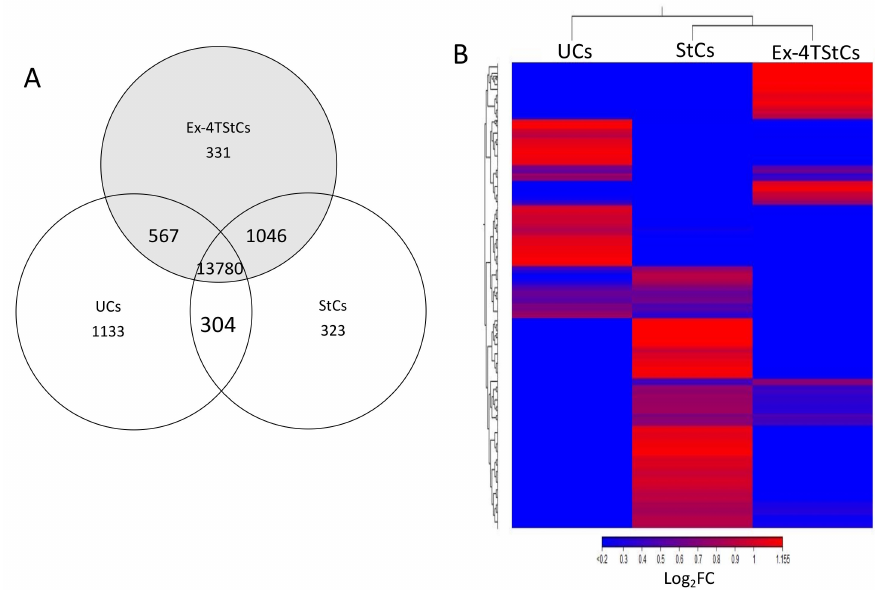
Figure 1. Differentially expressed genes between untreated, steatotic, and Ex-4-treated steatotic cells. ( A ) . Venn diagram showing the distribution of the genes affected by steatosis and the treatment with Ex-4 as determined by transcriptomics analysis. ( B ). Log 2 FC heatmap demonstrating overlap in DEG expression patterns in untreated steatotic, and Exendin-4 treated steatotic HepG2 cells. Rows and columns represent genes (1465) and samples, respectively. The heatmap is based on normalized gene expression (GE) values from each dataset. Dendrogram depicts hierarchical clustering of DEGs according to normalized GE values. The blue color indicates downregulated genes while the red indicates the upregulated genes. UCs: untreated cells; StCs: steatotic cells; EX-4-TStCs: Ex-4-treated steatotic cells. n = 3 for each